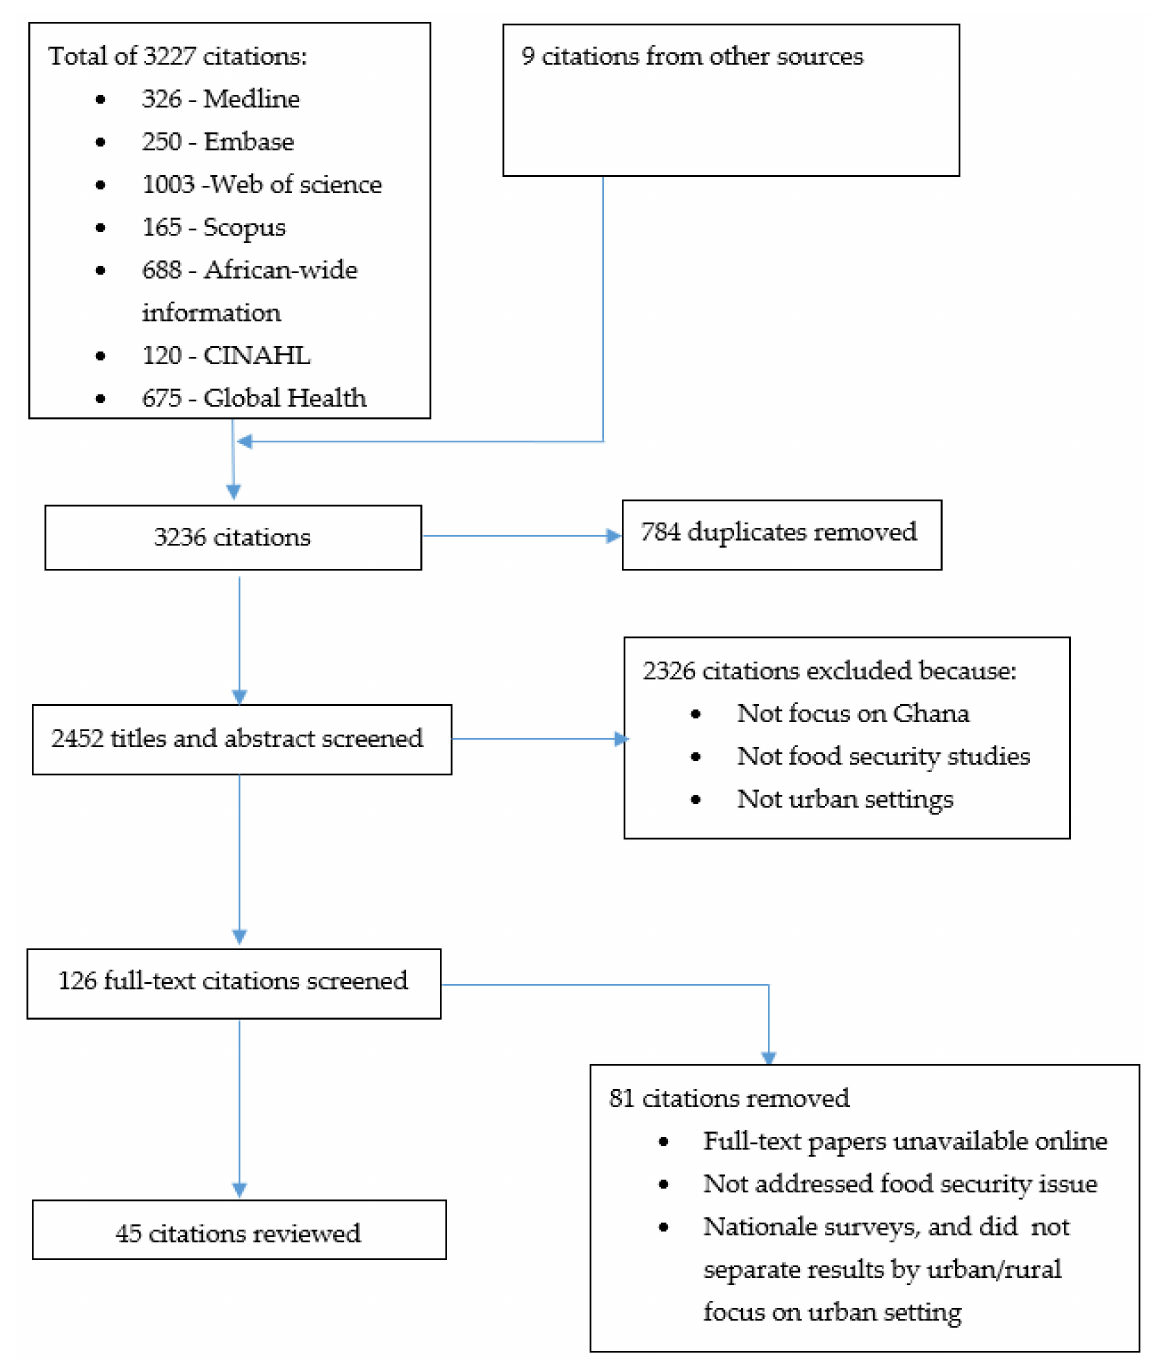
Figure 1. PRISMA flow chart describing the study selection